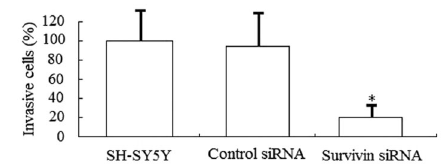
Figure 5. Cell migration assay in neuroblastoma SH-SY5Y cells. Quantitation of Matrigel-invaded cells underneath the membrane. Data are reported as means±SD of 3 independent experiments. *P , 0.01, compared with control siRNA (Mann-Whitney